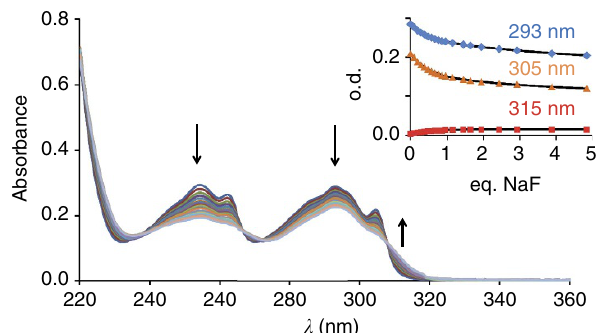
Figure 5 | DFT modelling. The [ErLF] monomer ( a ) and the [(ErL) 2 F] þ dimer ( b ) were modelled by DFTcalculations and revealed the presence of strong p – p stacking interactions between indazolyl groups in the dimer, together with four hydrogen bonding interactions which, with the formation of Er-F-Er bridge, stabilize the supramolecular dimeric